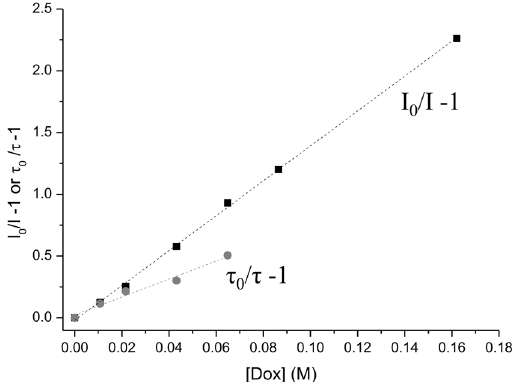
Figure 3. Stern–Volmer plots of the probe DPH in DMPC:SM [8:2] model at pH 7.4 and 37 °C with increasing doxorubicin concentrations: square symbols ( ◾ ) represent the Stern–Volmer plot obtained by steady-state fluorescence measurements (I 0 /I − 1) and circle symbols ( ) represent the Stern–Volmer plot obtained by lifetime fluorescence measurements ( τ 0 / τ− 1).